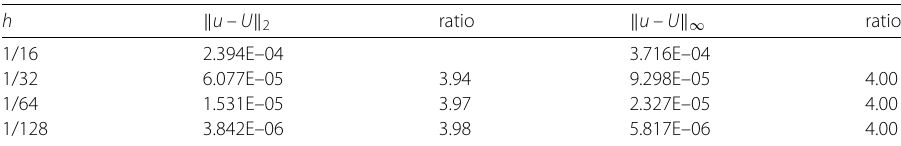
Table 5 The errors for finite difference solutions in two norms